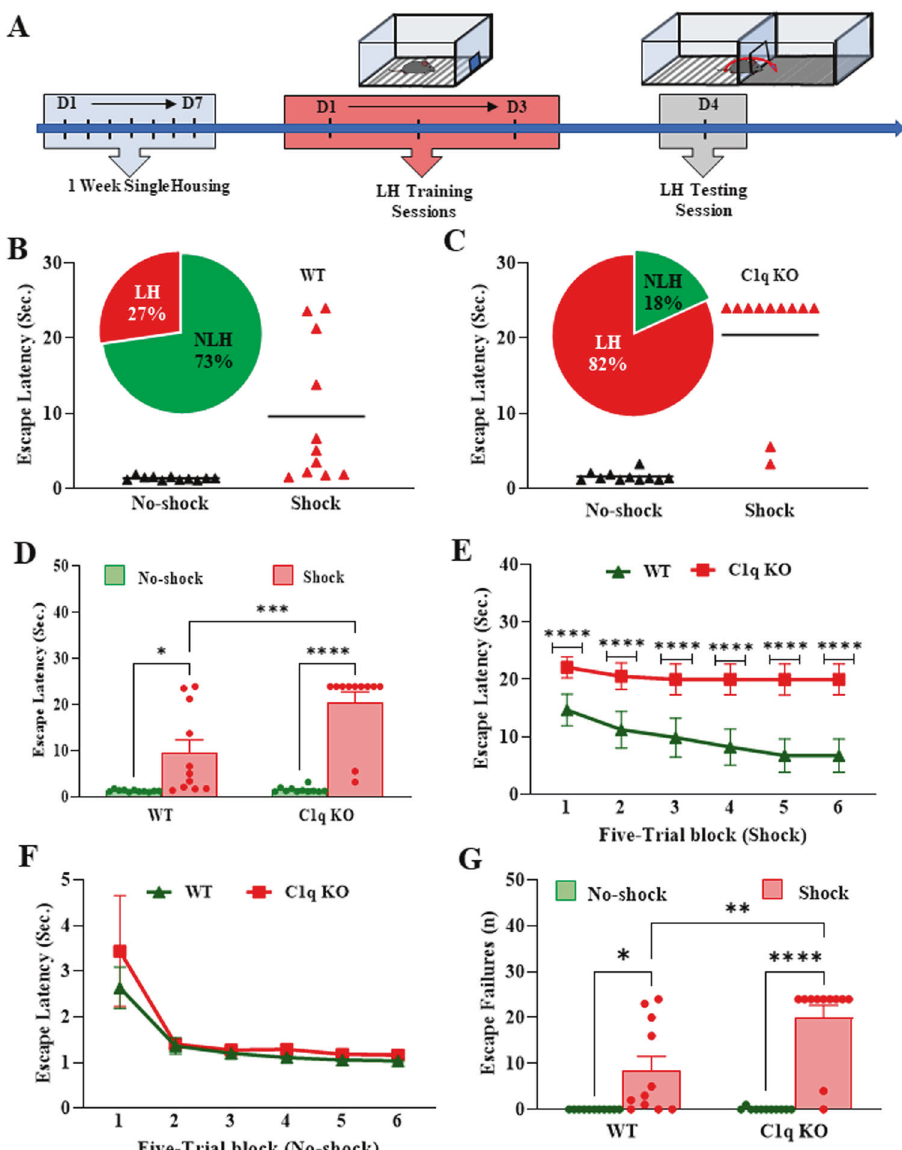
Fig. 2 C1q deletion exacerbates the stress-induced helplessness behavior in mice. A Learned helplessness (LH) paradigm. B , C Percentage of mice exhibiting helplessness. D Mean escape latency in an escape test. Two-way ANOVA, genotype X shock interaction (F (1, 40) = 8.313, p = 0.0063); Tukey ’ s multiple comparisons; * p = 0.0161 vs no-shock WT, *** p = 0.0009 vs shock WT, **** p < 0.0001 vs no-shock C1q KO. Mean escape latency per fi ve-trial block in E shock and F no-shock groups. E Two-way repeated-measures ANOVA, genotype X number of block interaction (F (5, 50) = 3.901, p = 0.0046); Tukey ’ s multiple comparisons; **** p < 0.0001 vs shock WT. G Number of escape failures. A trial was considered to be an escape failure when a mouse failed to escape a 0.3 mA foot shock within 24 s. Two-way ANOVA, genotype X shock interaction (F (1, 40) = 7.902, p = 0.0076); Tukey ’ s multiple comparisons; * p = 0.0236 vs no-shock WT, ** p = 0.0014 vs shock WT, **** p < 0.0001 vs no-shock C1q KO. Data are presented as percentage (%) or mean ± SEM. N = 11 per and unpredictable EFSs on cytokine levels in the PFC and serum. We performed the cytokine array of 13 cytokines in the PFC and serum samples of shock and no-shock WT and C1q KO mice. Out of 13 cytokines, IL-10 and IL-6 were not detected in the PFC